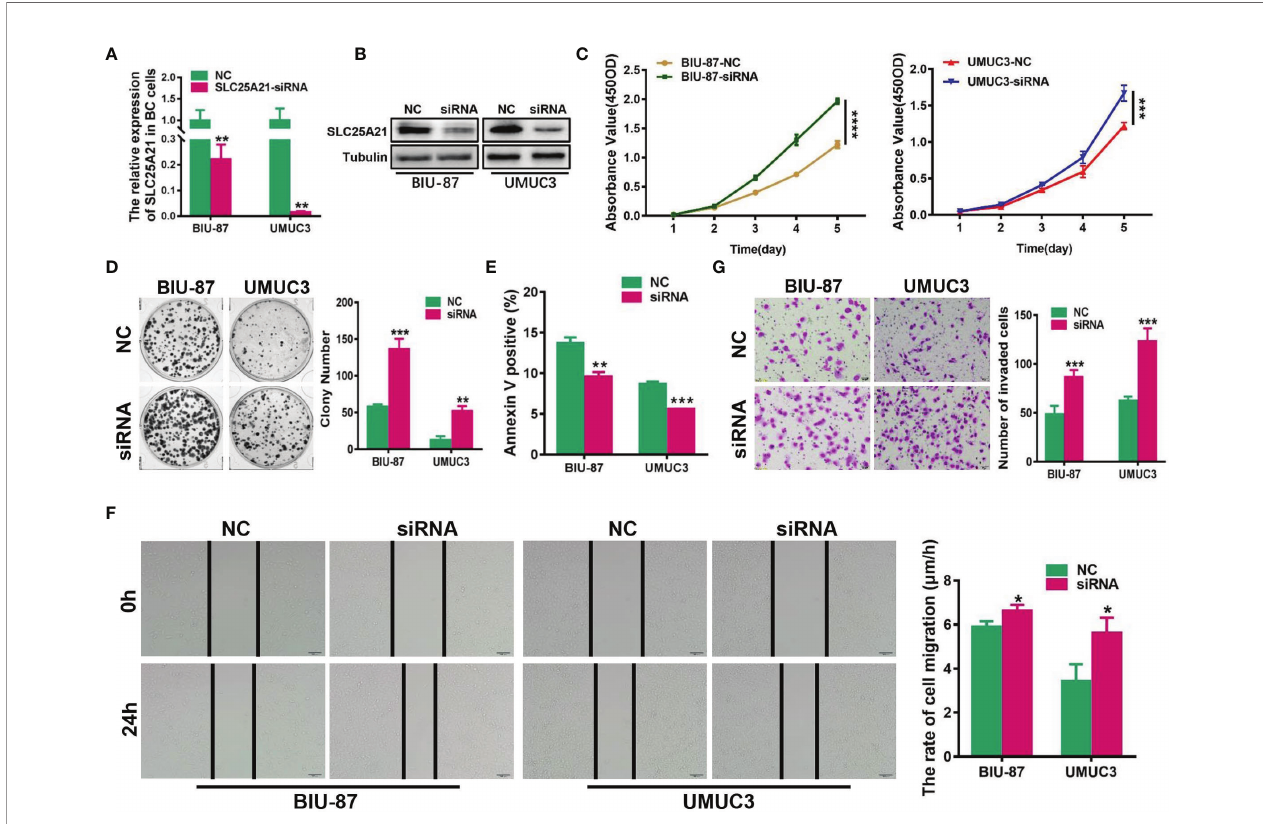
FIGURE 4 | siRNA-mediated knockdown of SLC25A21 promotes BCa cell proliferation, migration and invasion, and represses cell apoptosis in vitro . (A, B) Depletion of SLC25A21 after transient transfection of siRNA targeting SLC25A21 was con fi rmed in two BCa cell lines by real-time RT-PCR (A) and western blotting (B) . (C, D) The effects of SLC25A21 downregulation on BCa cell proliferation by CCK-8 (C) and colony formation assays (D) . (E) The effects of SLC25A21 depletion on cell apoptosis (E) by fl ow cytometry. (F) The effects of SLC25A21 depletion on the migration ability of BCa cells by using a wound healing assay. (G) Invasion assays were used to determine the effects of SLC25A21 depletion on the invasion ability of BCa cells. Representative images (left) and quantitative analyses (right) are shown. Data are expressed as the means ± SD of three independent experiments. * P <0.05, ** P <0.01, *** P <0.001, and **** P